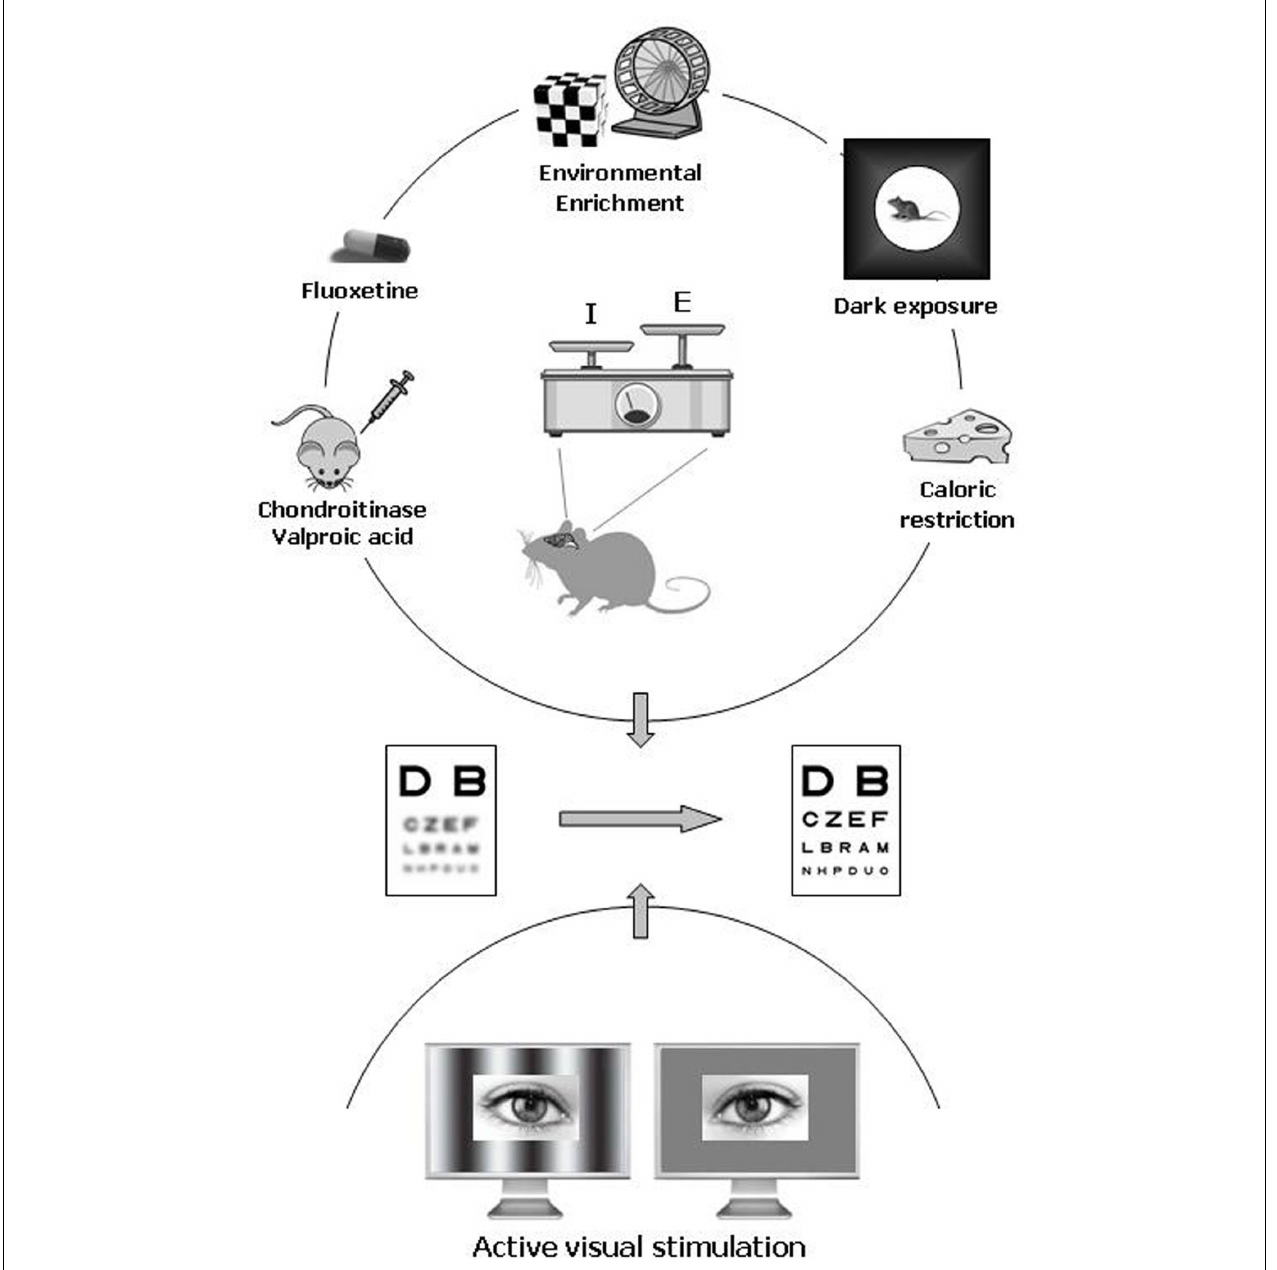
environmental enrichment, housing in complete darkness, or caloric restriction. In humans, emerging clinical studies point to active visual stimulation obtained with perceptual learning or playing video games as a promising strategy for treating amblyopia in adulthood. An increased ratio between excitation and inhibition owing to a reduced intracortical inhibitory tone is thought to be a central hub triggering plasticity in the adult visual